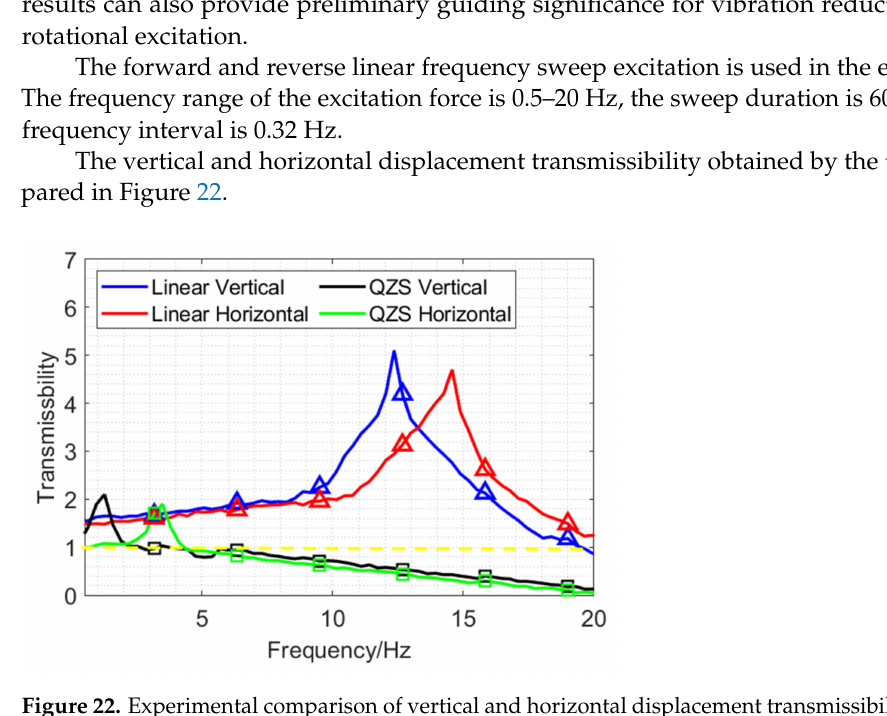
Figure 22. Experimental comparison of vertical and horizontal displacement transmissibility between the linear system and the